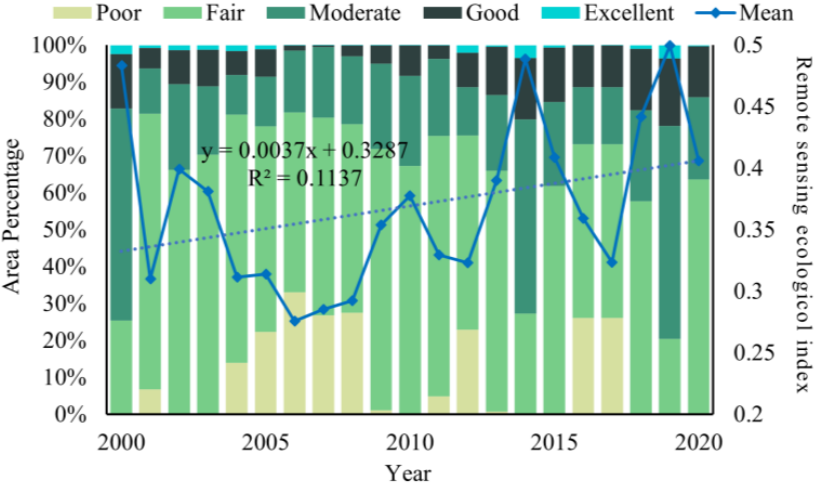
Figure 6. Mean plot on the UANSTM.